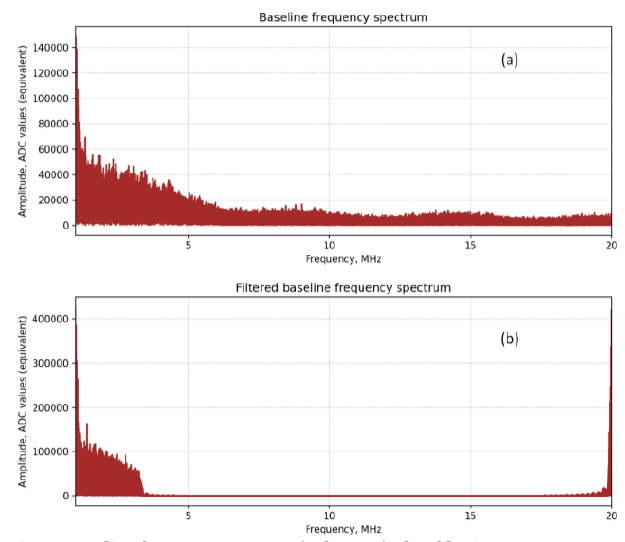
Fig. 8. Baseline frequency spectrum before and after filtering.